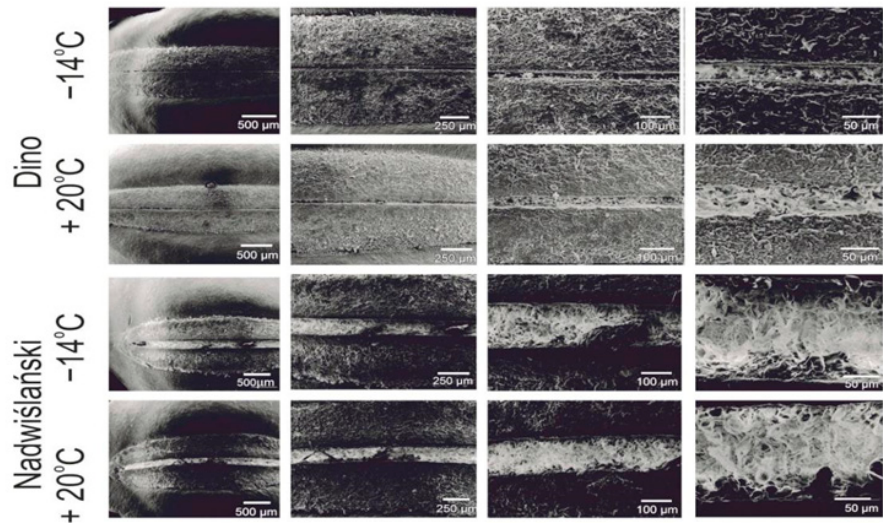
Figure 2. SEM images of seed hilum surface stored at different temperature. In one line are available for the same seeds at different magnifications (magnification ranging from 20X to approximately 200X, scale bar 500 to 50 μ m is shown).